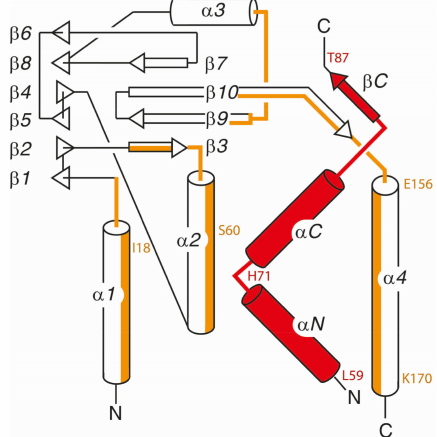
Figure 3. Conserved overall topology and secondary structure content displayed by all herpesviral core NEC structures. The segments of the pUL50 homologous groove proteins that interact with the pUL53 homologous hook segment (in red) are marked in orange. The color code depicts the main regions of hook-into-groove contacts, as similarly marked for the respective contact residues in Figure 4. To improve viewing, the location of some amino acids from HCMV pUL50 and pUL53 is indicated explicitly (see also Figure